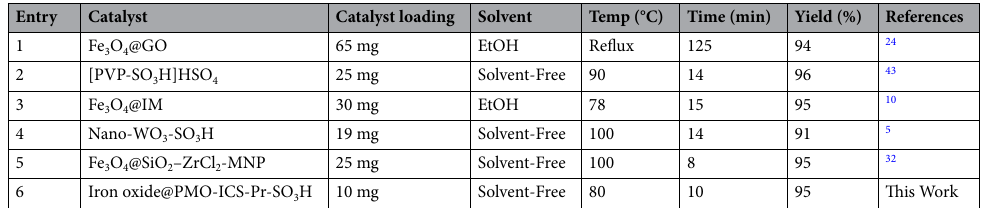
Entry Catalyst Catalyst loading